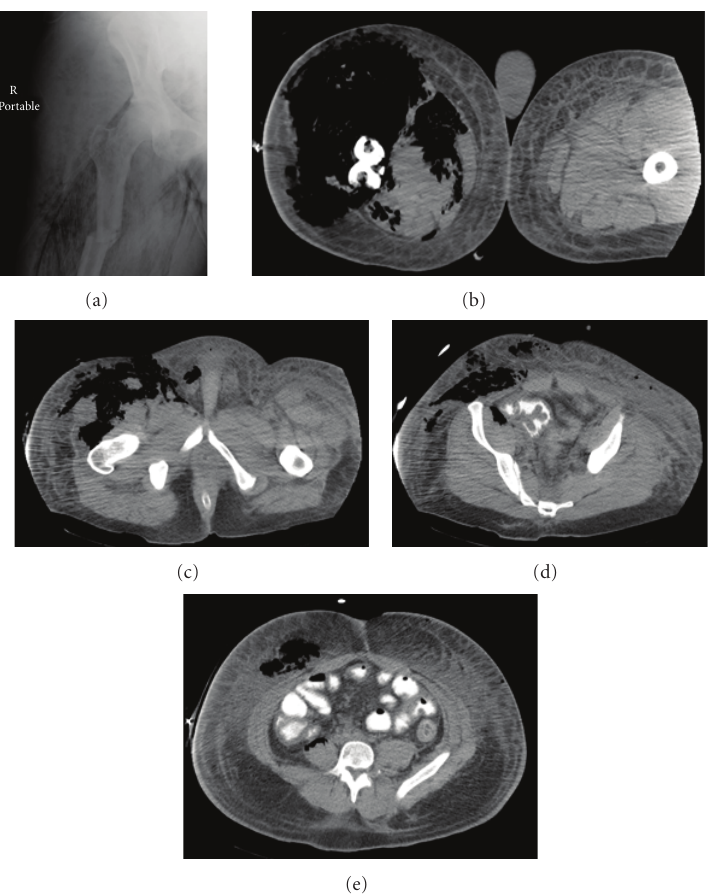
Figure 2: (a) Anteroposterior radiograph of proximal femoral fracture showing a significant amount of soft tissue gas, (b) computed tomography axial slice at the fracture site, showing significant, near-circumferential soft tissue gaseous necrosis, (c) a more proximal axial computed tomography cut showing the significant amount of anterior thigh and hip gaseous necrosis, (d) another more proximal axial computed tomography cut showing evidence of gaseous necrosis along the iliopsoas and anterior abdominal wall, and (e) this axial computed tomography cut shows the most cephalad extension of the soft tissue infection along the anterior abdominal